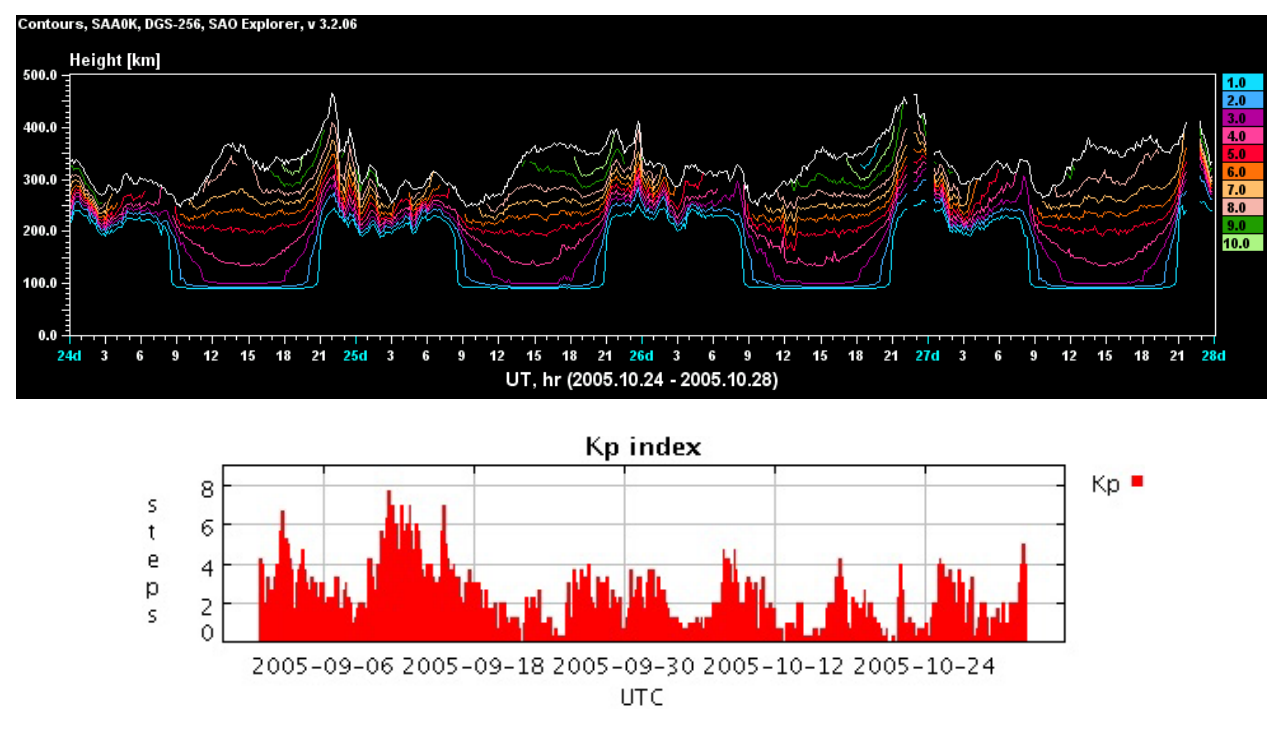
Fig. 8. Digisonde measurements at S˜ao Luis for 24 to 27 October 2005 (upper panel) showing significant perurbations of the bottomside F-layer and above ( ∼ 200 to 400km), especially on the first two nights. K p index (lower panel) during September and October 2005. Corresponding tabular data yield mean values of 1, 3.5, 2.5, and < 2 for 24 to 27 October, respectively, averaged in UT, suggesting only weak to moderate magnetic